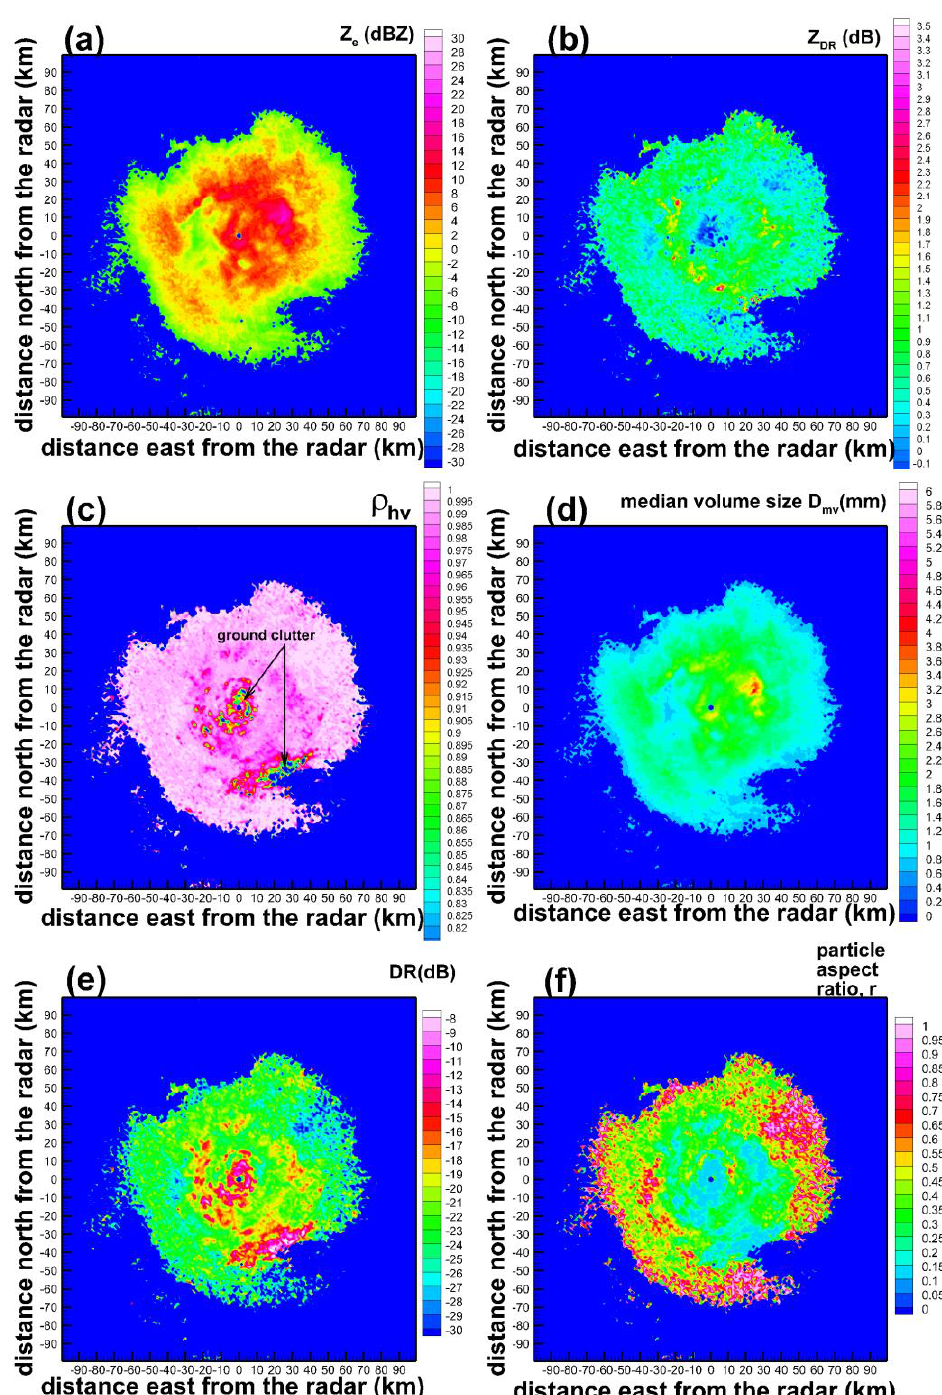
Figure 5. Measurements of horizontal polarization reflectivity ( a ), differential reflectivity ( b ), copolar correlation coefficient ( c ), estimates of depolarization ratio ( e ) and retrievals of particle median volume size ( d ) and aspect ratio ( f ) corresponding to a KDLH radar scan at 4.5° on 5 March 2013 at 19:27 UTC.